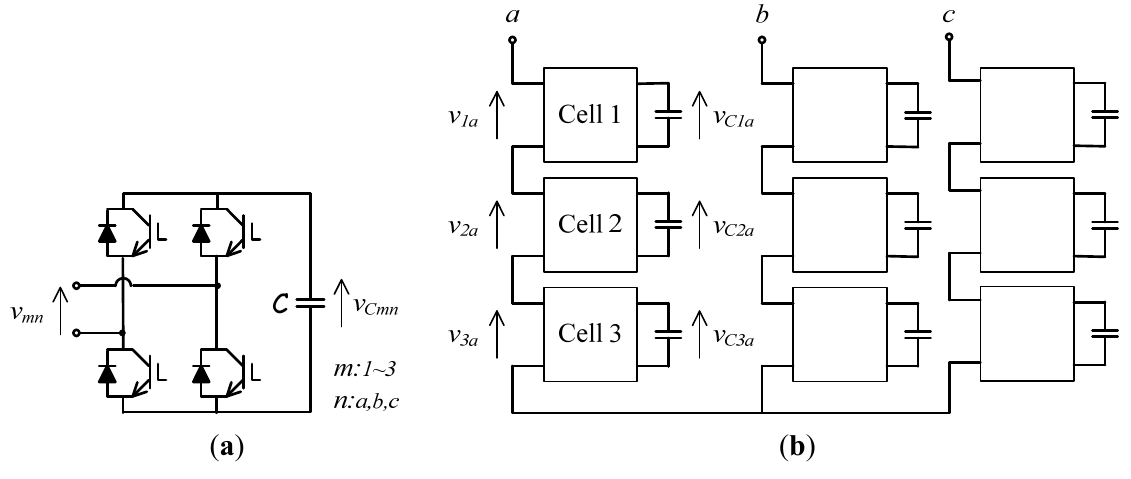
Figure 1. Asymmetric cascaded converter; ( a ) power cell topology; ( b ) converter topology. Table 1. Voltage distortion limits. Total Harmonic Bus Voltage at PCC